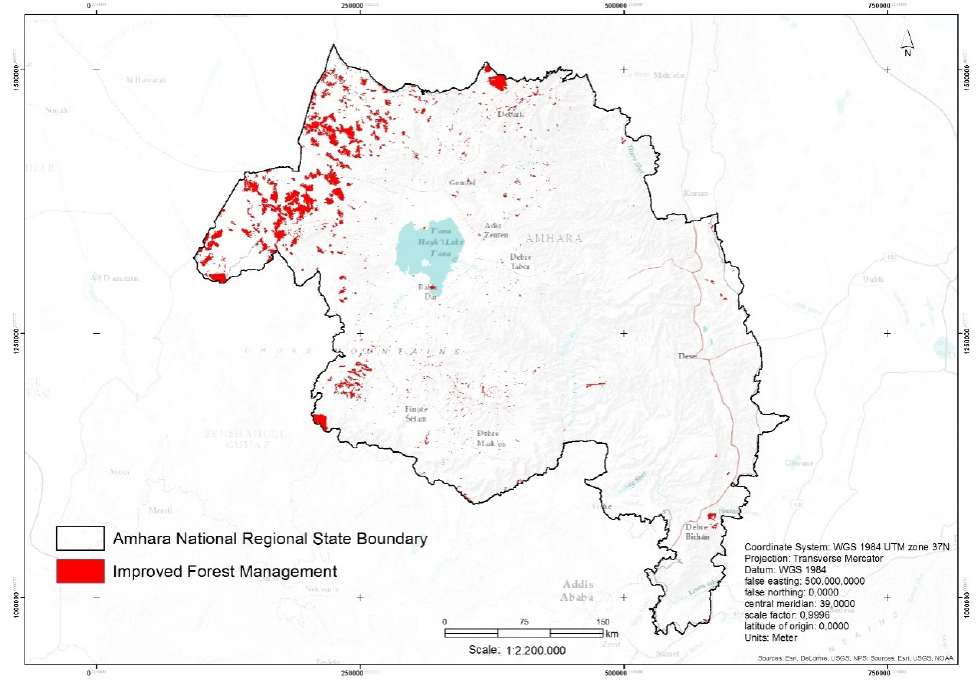
Figure 4. Opportunity areas for improved natural forest management.